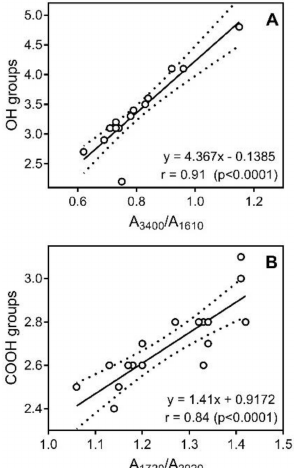
Figure 4. A plot of content of aromatic OH groups ( Panel A ) and COOH groups ( Panel B ) in the HA fractions versus ratio of intensity of the absorption bands in the IR region specific for OH groups (A 3400 /A 1610 ) ( Panel A ) and COOH groups (A 1720 /A 2920 ) ( Panel B ). Dashed lines indicate area of the 95% confidence band. Note that the symbols for HAb-4, HAb-6, HAp-6, HAb-8, and HAp-8 overlap in ( Panel A ), and the symbols for HAb-1 and HAb-3 overlap in ( Panel B ).